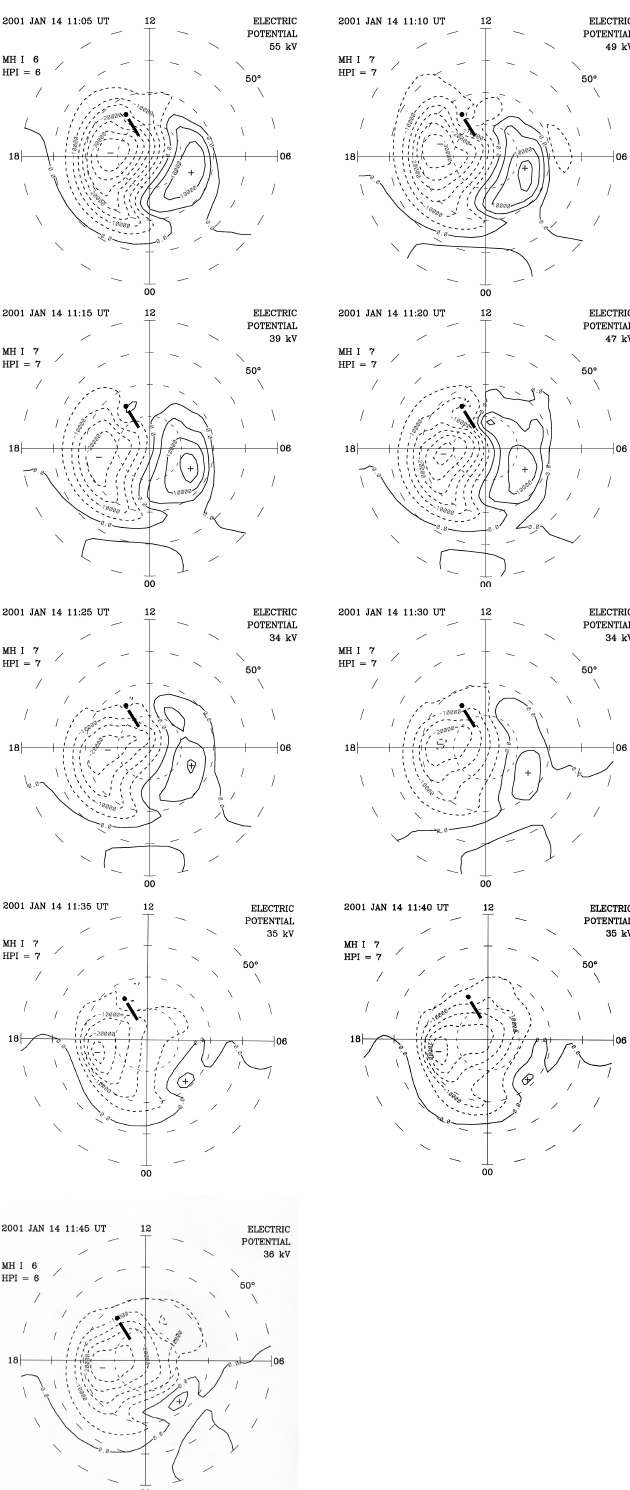
Fig. 6. The sequence of 5min integrated AMIE convection patterns for 11:05–11:45. The locations of the two ESR beams are shown in each